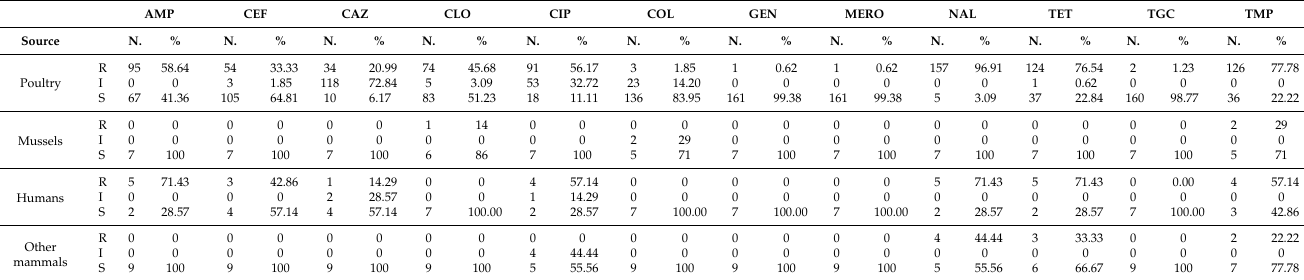
Low levels of resistance were observed in strains isolated from mussels and other mammals (cow/calves, water buffalo, wild boars, and pigs) (Table 2). The lower suscepti- bility of poultry strains compared to those from other sources was statistically significant (X 2 = 74; p < 0.05,OR = 147).